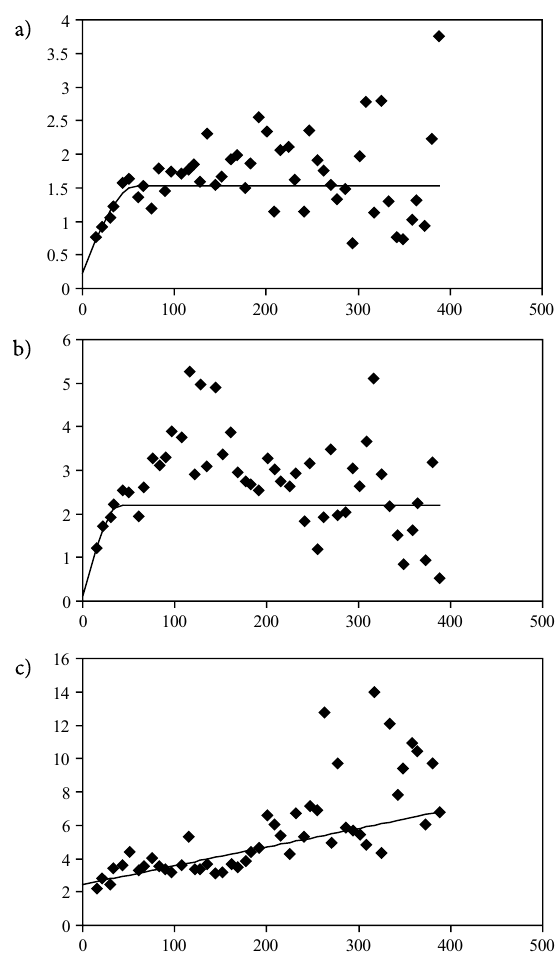
Fig. 8. a – empirical semivariogram together with the best goodness of fit spherical model for the recordings of L-type original Schmidt rebound hammer; b – empirical semivariogram together with the best goodness of fit spherical model for the recordings of N-type original Schmidt rebound hammer; c – empirical semivariogram together with the best goodness of fit spherical model for the recordings of N-type Silver Schmidt rebound